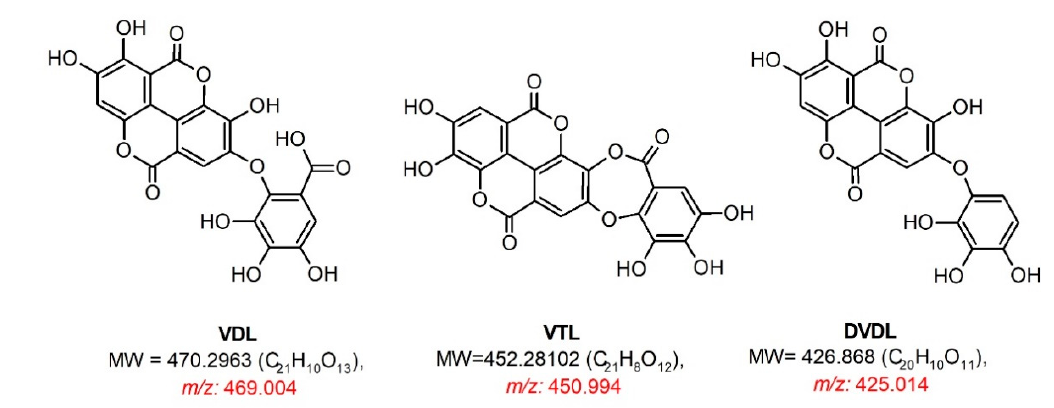
Figure 4. Products of the fragmentation of ellagitannins (depsides). Abbreviations: EA, ellagic acid; LHHDP, decarboxylated hexahydroxydiphenic acid monolactone; HHBP, 2,2 ′ ,3,3 ′ ,4,4 ′ -hexahydroxybiphenyl; VDL, valoneic acid dilactone; VTL, valoneic acid trilactone; DVDL, decarboxylated valoneic acid dilactone; MW, molecular weight (Da).